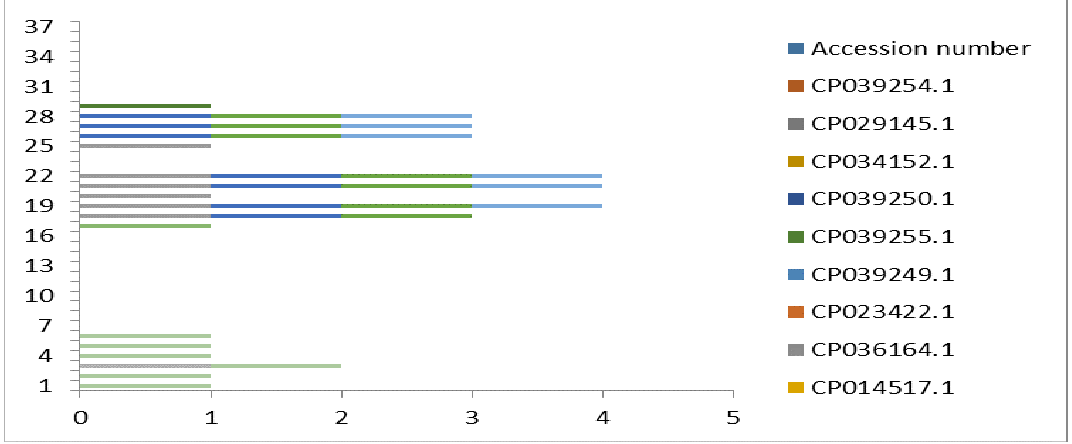
Figure 3 . Resistant gene categorized under “perfect” and their accession numbers.